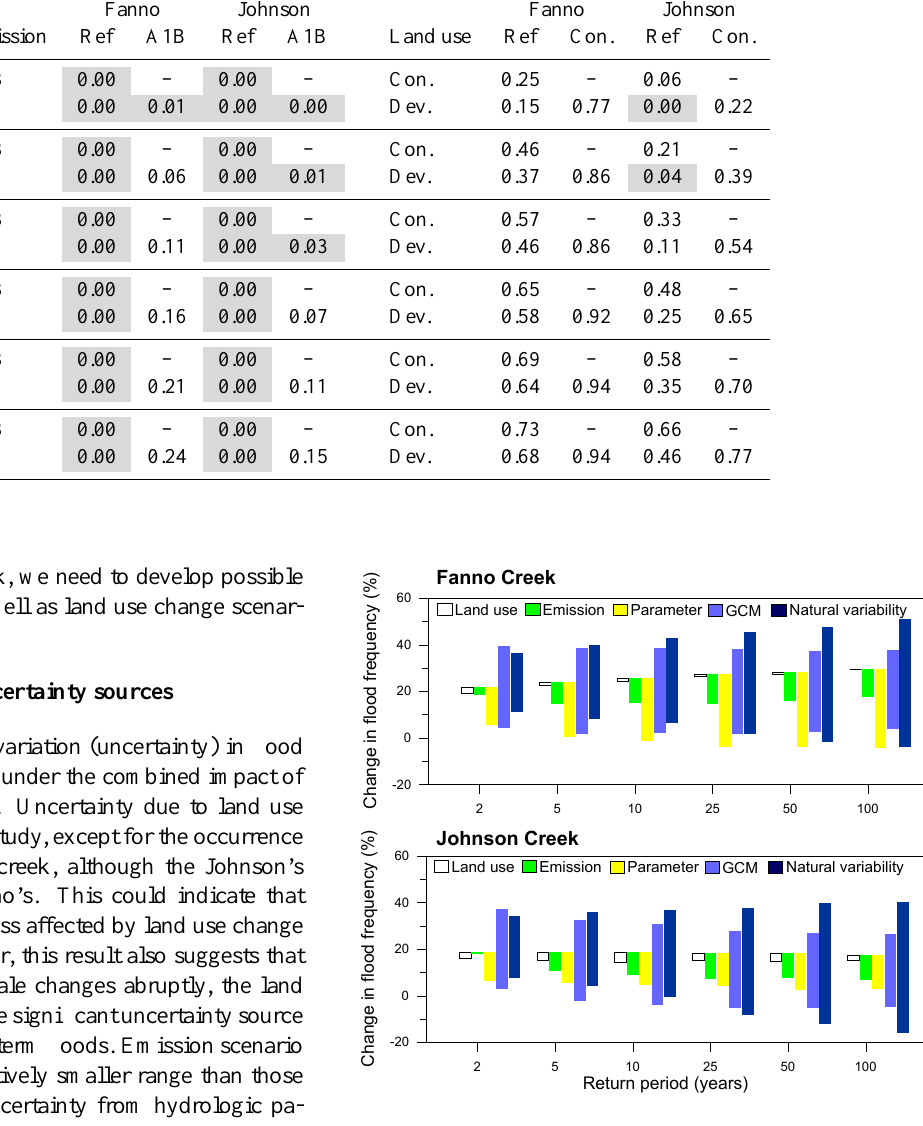
Fig. 10. Comparison of variation in flood frequency change by each uncertainty source. The vertical ranges show the 95% confidence interval. 4